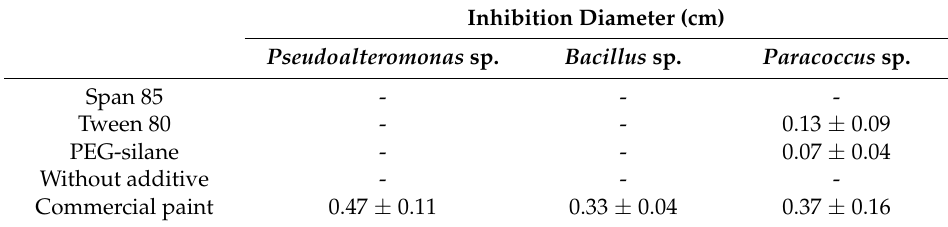
Table 1. Inhibition zone diameter of coatings against Pseudoalteromonas sp., Bacillus sp., Paracoccus